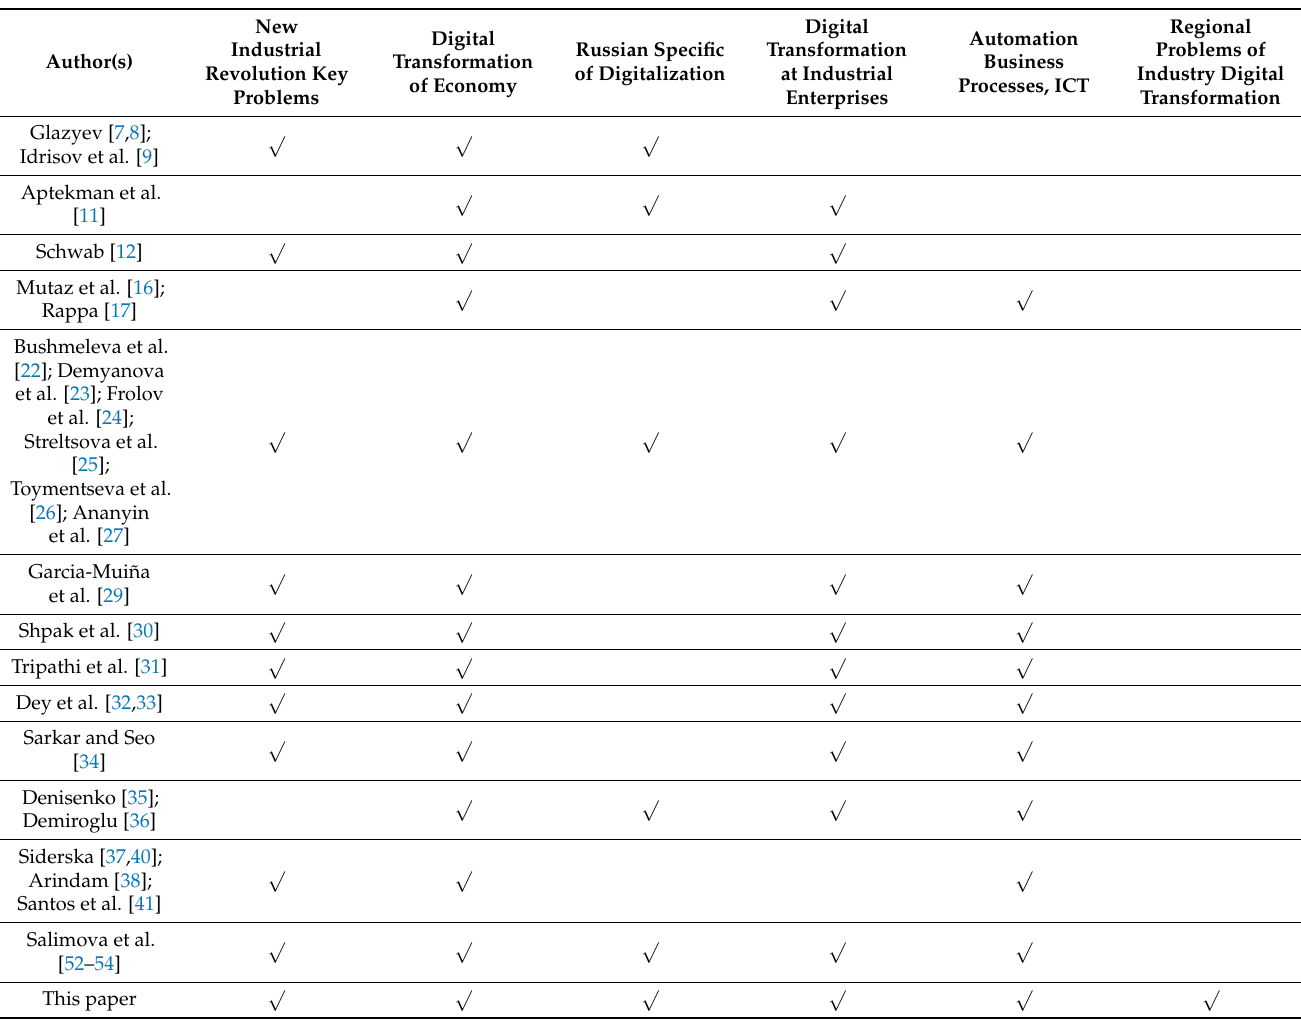
Table 1. Comparative study with the existing